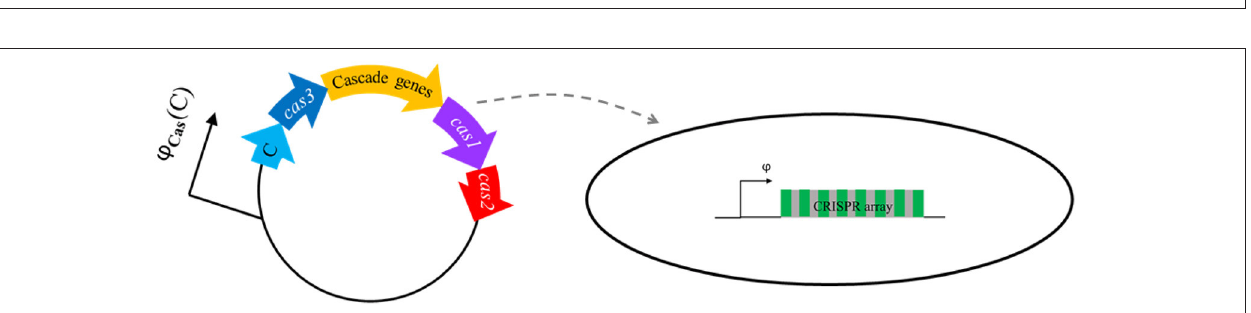
FIGURE 2 | (A) A scheme of CRISPR transcript processing: CRISPR array is transcribed (i.e., pre-crRNA is generated) with rate ϕ , and the transcript is either (non-specifically) degraded with rate λ pre , or processed to crRNAs by Cas6e with rate k ; individual crRNAs are then degraded with rate λ crRNA (Djordjevic et al., 2012). (B) The proposed model system for CRISPR-Cas activation: cas genes (including cas6e , whose product processes pre-crRNA to crRNA), and the transcription factor (C), are transcribed from ϕ Cas promoter. To reproduce the same qualitative features of transcription regulation as in a native CRISPR-Cas system (cooperative regulation), ϕ Cas is put under control of C protein, in the same manner as in a well-studied AhdI R-M system ( Bogdanova et al., 2008). The system is induced when the plasmid expressing cas genes and C protein enters a bacterial cell, as indicated in Figure 3 . Gradual expression of cas genes, leading to Cas6e protein synthesis (gray oval), then increases k (this is indicated by the full arrow in the figure), which in turn results in crRNA generation.